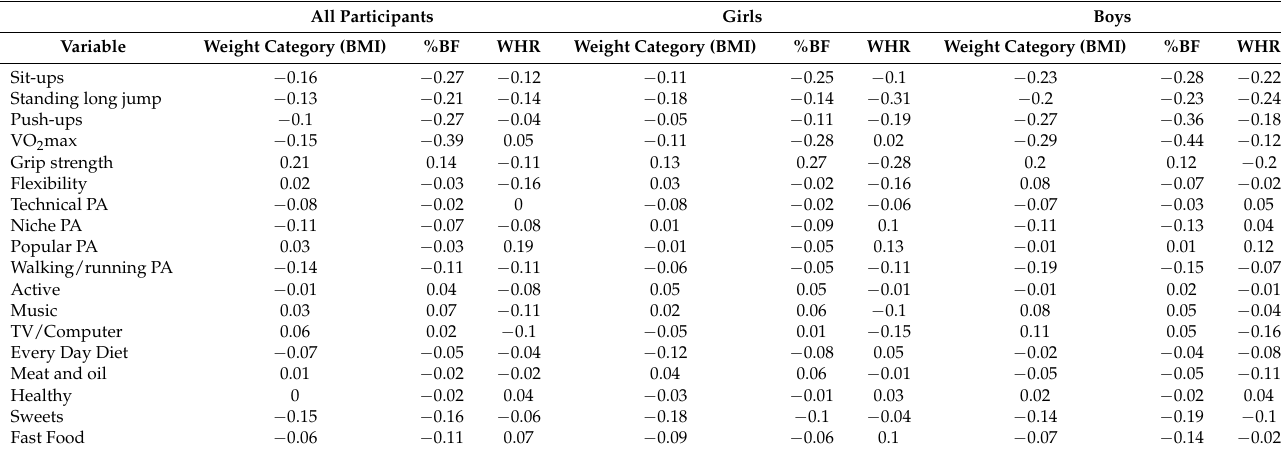
Table 4. Correlation coefficients calculated for all variables for all participants and for girls and boys separately. Bold and enlarged numbers indicate the statistical significance at p < 0.05.